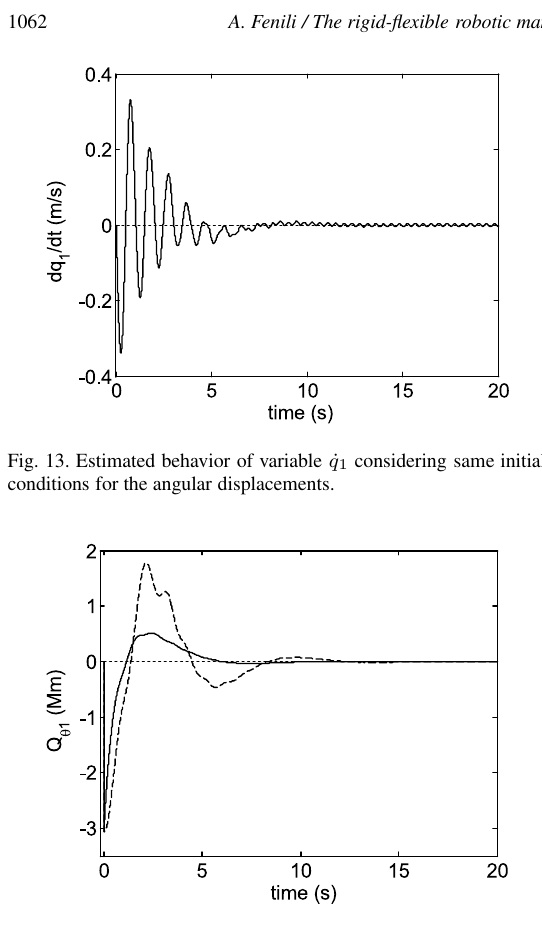
Fig. 15. Control torque Q θ 1 considering same initial conditions (—) and different initial conditions (- - -) for the angular displacements.